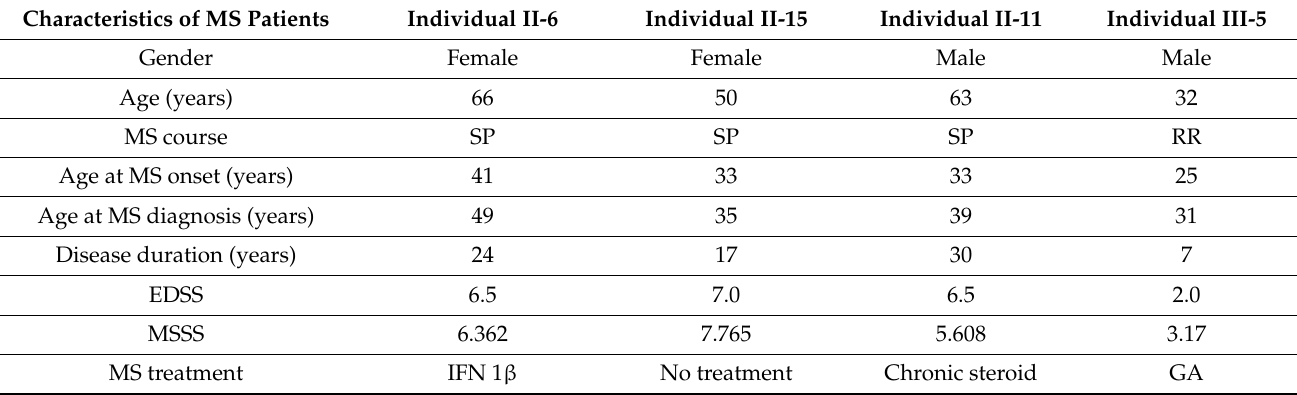
Figure 3. Pedigree of the multiplex MS family and segregation of GRAMD1B c.1801T > C (p.S601P) variant. Squares represent men, circles represent women; slash, deceased subjects; black-filled symbols represent individuals diagnosed with MS. The first-cousin marriage between two unaffected individuals, subject I-1 and subject I-2, is indicated by a double line. +/+: homozygous individuals for mutated allele; −/−: homozygous individuals for wild-type allele; +/−: heterozygous individuals. The numbers reported inside circles and squares indicate age at sampling of the subject. The smaller arrowhead represents the proband; larger thick arrows represent samples subjected to whole-genome sequencing. Table 1. Demographic and clinical features of multiple sclerosis patients of the multiplex family.